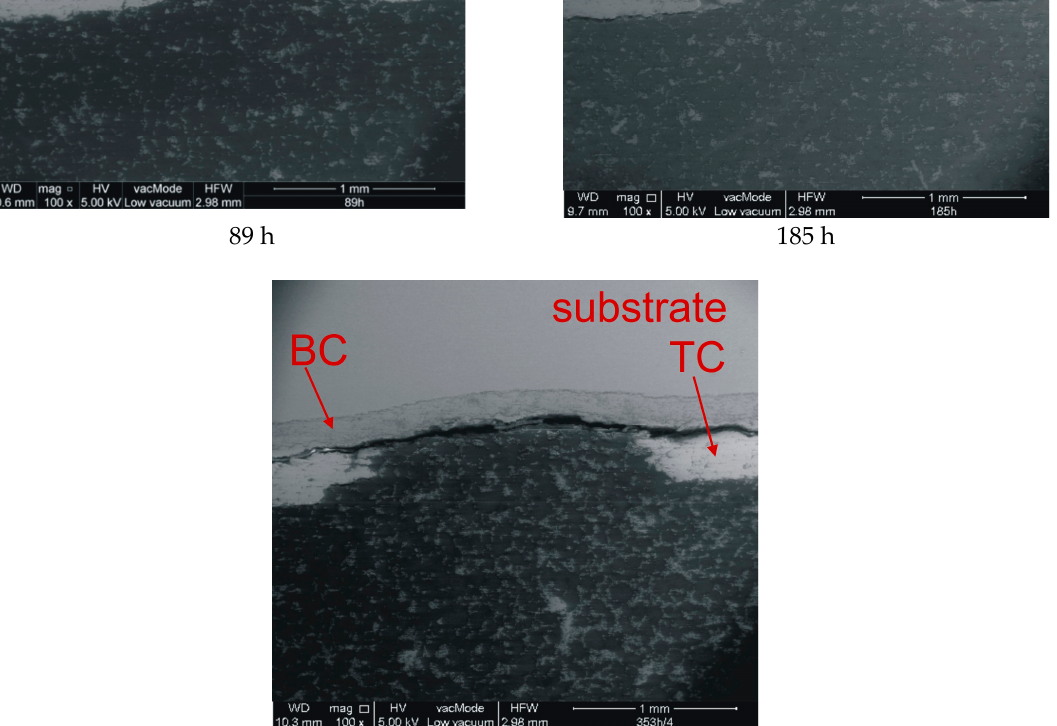
Figure 2. Images of indents for impact no. 1 and various aging times. BC: bond coat; TC: top coat. For aging times from 48 to 185 h, the ceramic edges in the area of erosion were irregular, and their diameters were 0.76, 1, and 1.05 mm, respectively. The largest diameter of the removed ceramic fragment was observed in the sample subjected to aging for 353 h, and it was approximately 2.06 mm. In one of the images for the first indent (0 h), we can clearly distinguish di ff erent damage areas of the ceramic